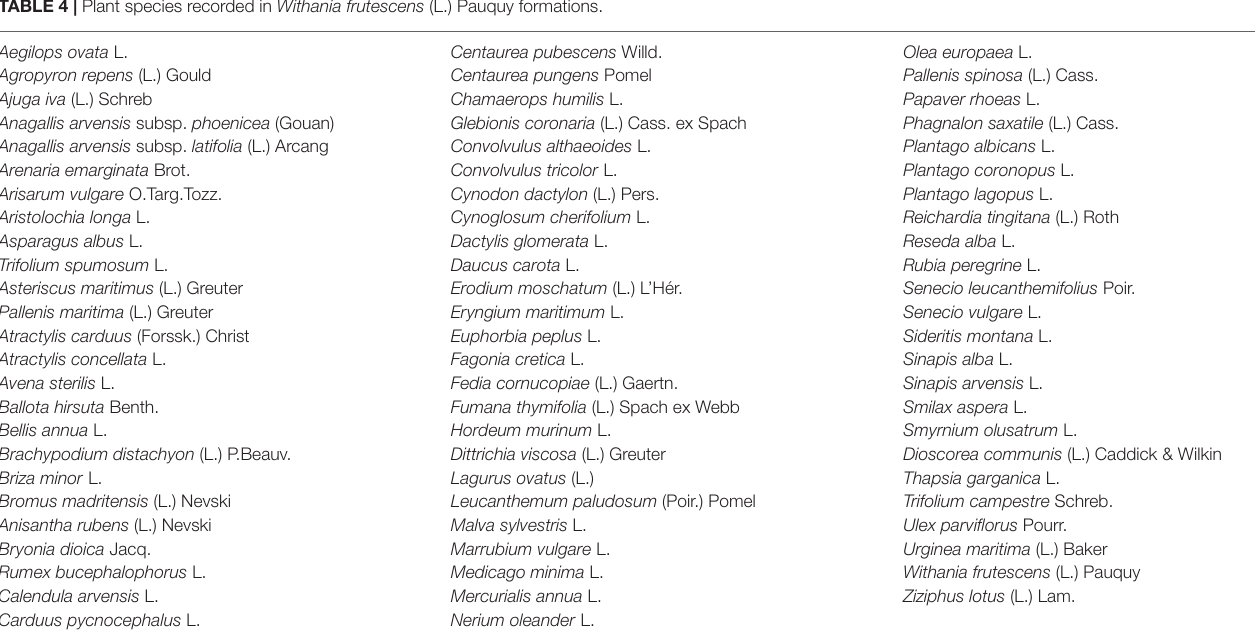
TABLE 4 | Plant species recorded in Withania frutescens (L.) Pauquy